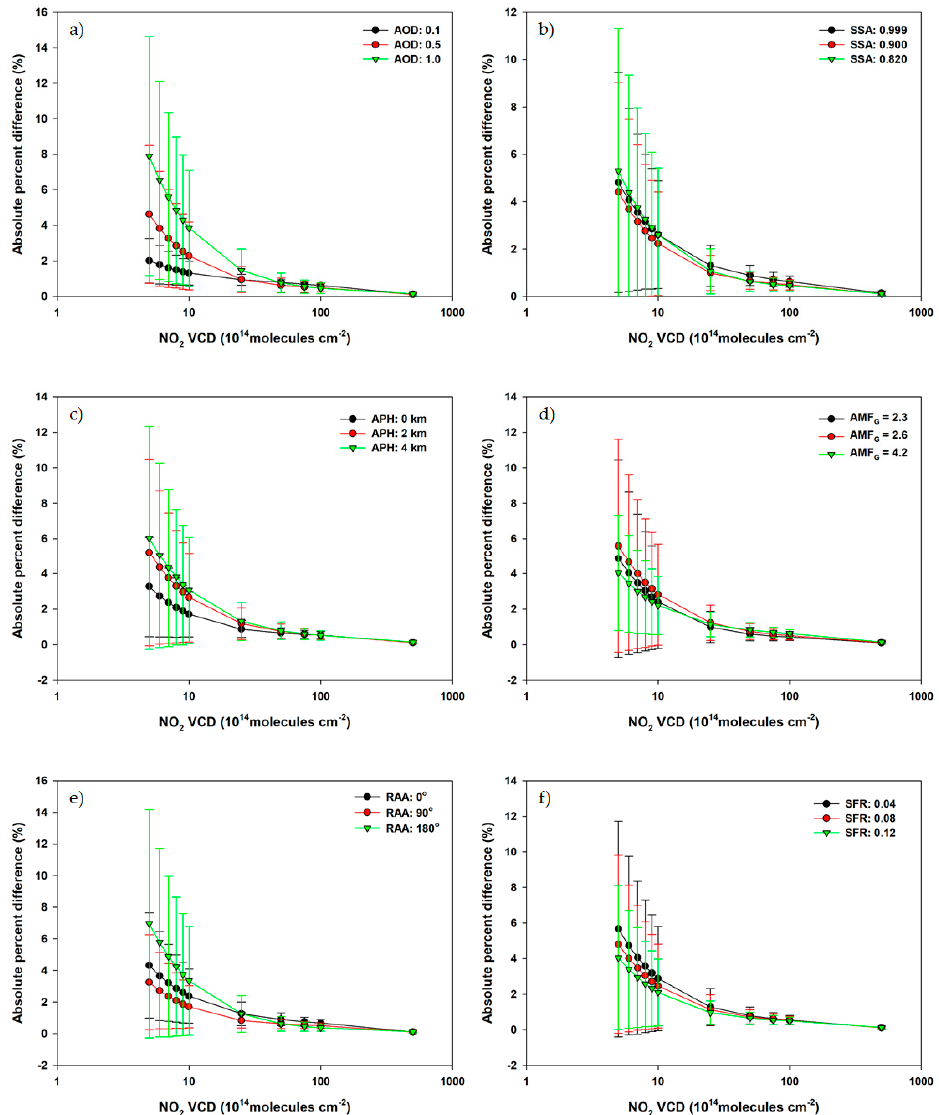
Figure 5. Absolute percentage difference (APD) under no-noise conditions between true and retrieved NO 2 SCDs as a function of NO 2 VCD with ( a ) AOD of 0.1, 0.5, and 1.0; ( b ) SSA of 0.999, 0.900, and 0.820; ( c ) APH of 0, 2, and 4 km; ( d ) AMF G of 2.3, 2.6, and 4.2; ( e ) RAA of 0°, 90°, and 180°; and ( f ) SFR of 0.04, 0.08, and 0.12. (Slant column density (SCD), vertical column density (VCD), aerosol optical depth (AOD), single scattering albedo (SSA), aerosol peak height (APH), air mass factor (AMF), relative azimuth angle (RAA), and surface reflectance (SFR)).